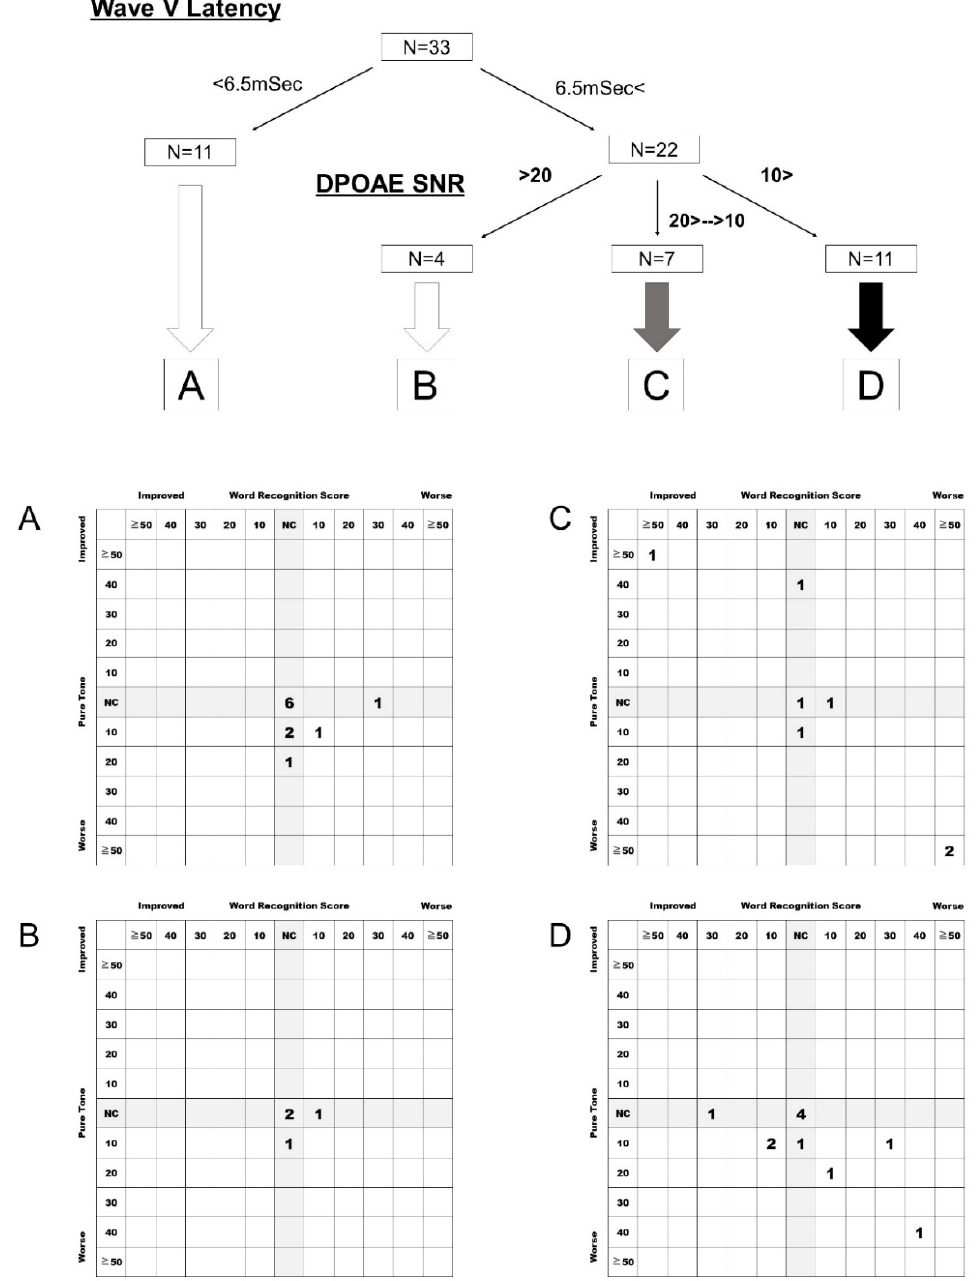
Figure 4. Postoperative hearing preservation rate based on our previous classification. In class A patients, hearing preservation was achieved in nine of 11 patients (82%). In class B, four of four patients (100%) had preserved preoperative hearing levels. In class C, five of seven (71%) patients achieved hearing preservation, while two of seven lost hearing ability. In class D, eight of 11 patients (73%) had preserved hearing levels postoperatively. NC, No change.